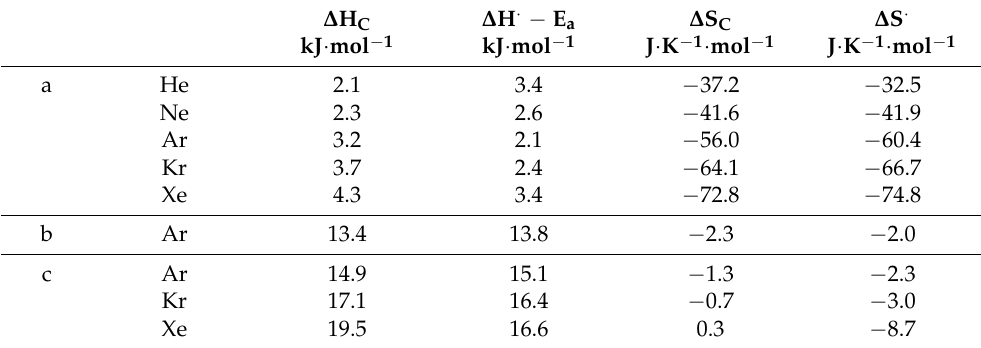
Table 2. Enthalpy and entropy changes associated with cavity creation in water (a), CCl 4 (b), and C 6 H 6 (c), calculated by means of the classic SPT relationships at 25 ◦ C and 1 atm, to be compared with the reorganization enthalpy change and the total solvation entropy change,